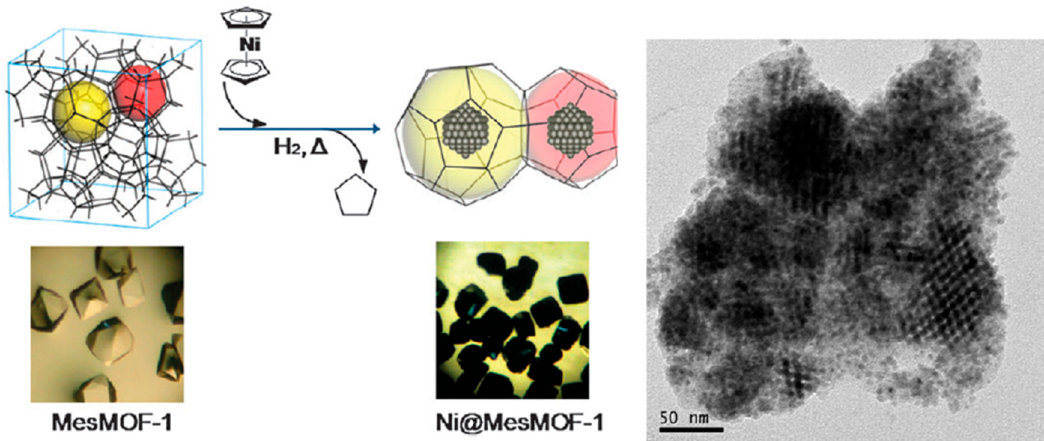
Figure 8. Two-step procedure for the preparation of Ni@Mesoporous-MOF-1. The pictures for the mesoporous MOF crystals before and after Ni embedment. The rightmost panel shows a TEM image of mesoporous MOF (30 wt%) where lattice fringes are observed, indicating Ni NPs are aligned with a long range order. Reproduced with permission from [59].